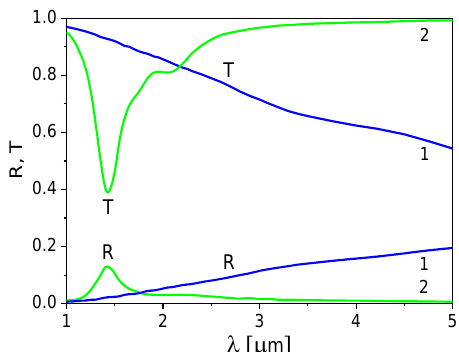
Figure 6. Influence of the director reorientation from the twisted to homeotropic state on the reflection and transmission spectra of the ITO nanoribbon grating: twisted state—curves 1 and homeotropic state—curves 2. Grating spacing Λ = 150 nm and ribbon aspect ratio d / Λ = 0.25. Calculations were performed using COMSOL software.